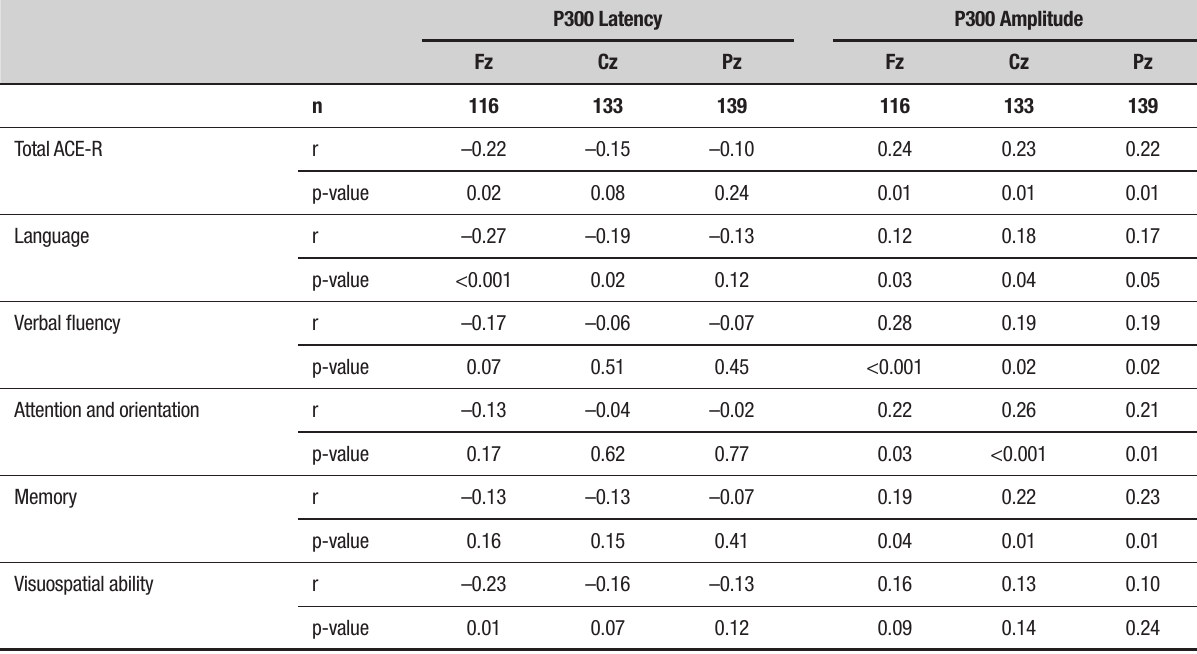
Table 1. Correlation matrix between P300 latency and amplitude and performance of elderly individuals on cognitive domains assessed by the ACE-R (n=149). São Carlos, SP, Brazil, 2017.